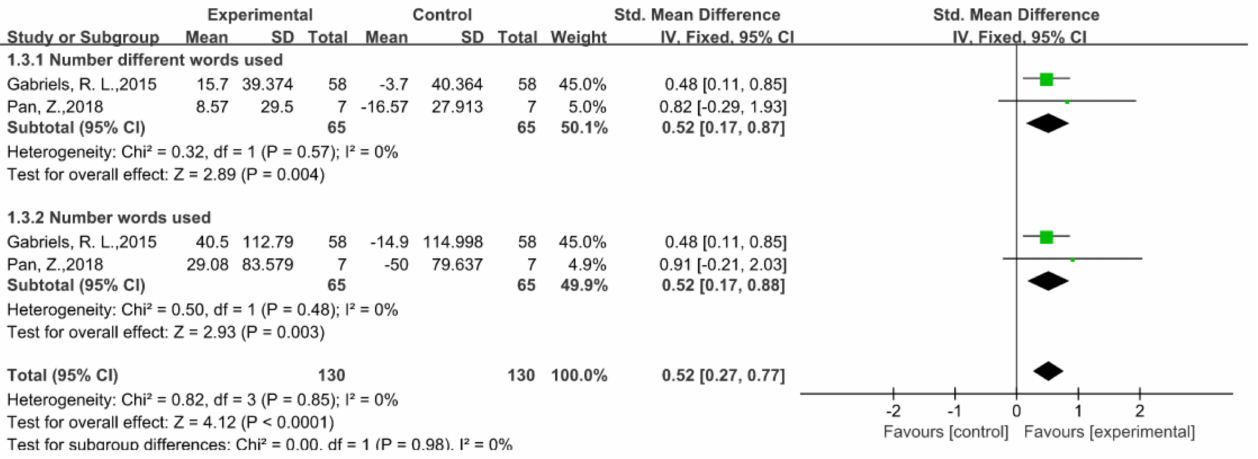
Figure 4. Forest plot of language ability using SALT